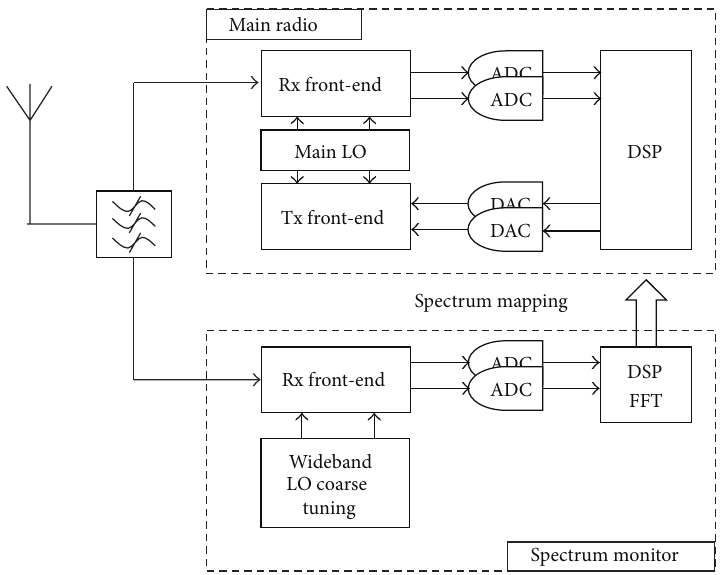
Figure 9: Spectrum monitoring and mapping scheme